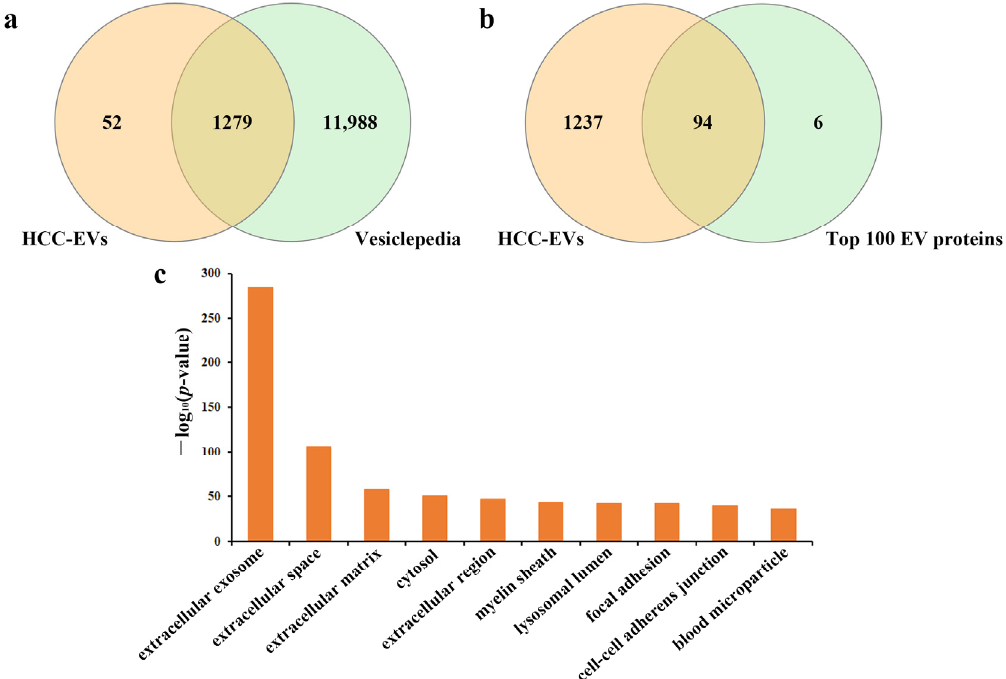
Figure 2. Venn diagram depicted the overlap of proteins identified from HCC-derived urinary EVs with those published in the Vesiclepedia database ( a ) and top 100 EV proteins from Vesiclepedia ( b ). ( c ) GO cellular component annotations of the identified proteins in HCC-derived urinary EVs.